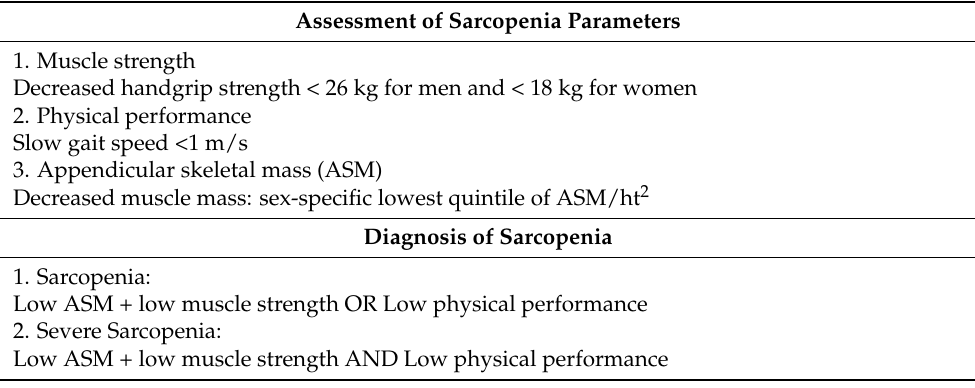
Table 2. Diagnosis of